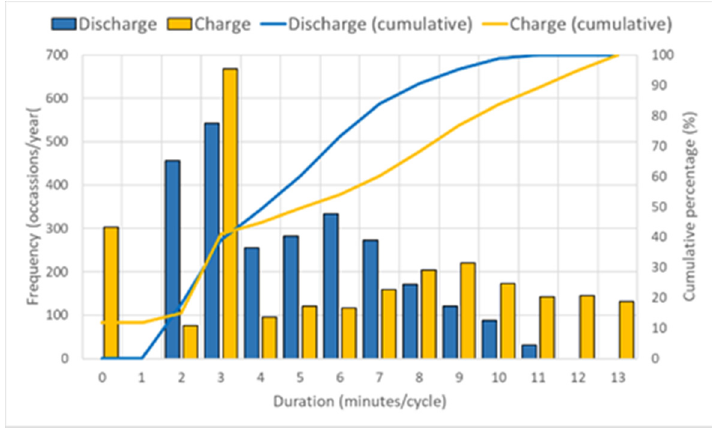
Figure 12. Frequency of charge/ discharge duration of calls for a 7 cycle/day case.